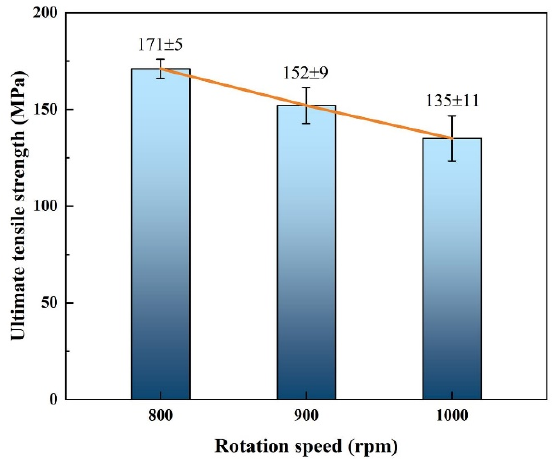
Figure 13. Ultimate tensile strength of the SFSW joints fabricated at different rotational velocities.